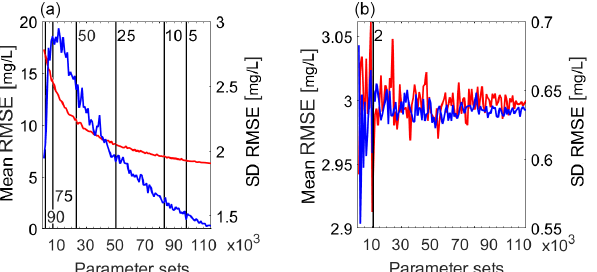
Figure 6. Mean (red lines, left axes) and standard deviation (blue lines, right axes) for RMSE values relative to the top 10% of the modelling results as a function of the number of parameter sets used in the TSM. The results are reported for the (a) first TSM iteration and the (b) last TSM iteration (E1). Vertical black lines indicate the number of parameter sets needed to have the shown percentage dif- ference between the mean RMSE value calculated at the indicated number of parameter sets and at 115000 parameter sets. For exam- ple, in plot (a) only using at least 50000 parameter sets, there is less than a 25% difference in the top 10% RMSE values compared to results using 115000 parameter